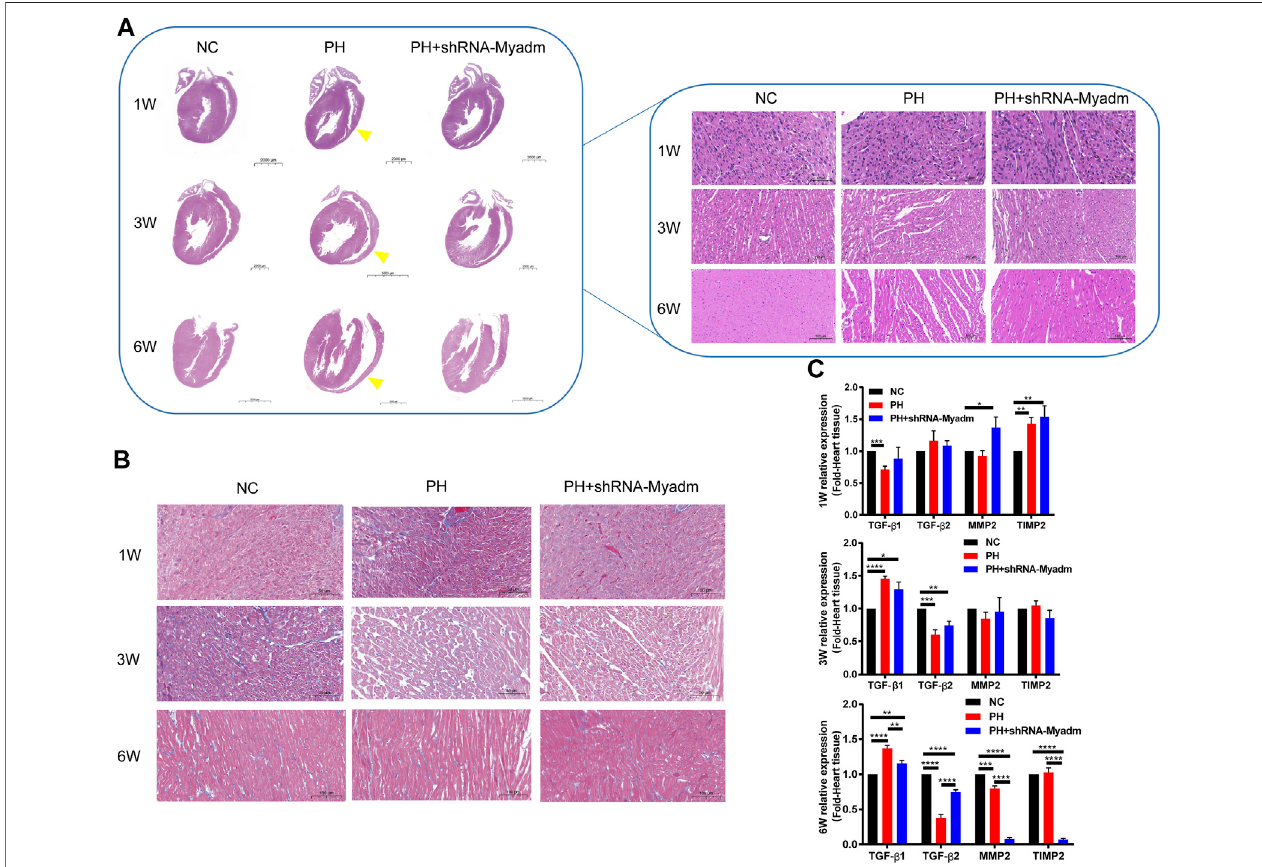
FIGURE9| Cardiac changesinrat offspring innormal, maternal PH,and interventiongroups. (A) RepresentativeH&E-stained hearts ofratoffspring at each age in each group. The left images show the entire heart, and the right images show the section of the right ventricular wall. Yellow arrows show thinner right ventricular walls and larger right cardiac chambers of maternal PH rat offspring as they grow up. (B) Representative Masson ’ s staining at each age in each group. (B) The mRNA expression ofTGF- β 1,TGF- β 2, MMP2,and TIMP2inthehearttissue ofoffspringineach groupand at each age.* p < 0.05,** p < 0.01, *** p < 0.001,**** p < 0.0001 vs. the normal pregnancy group ( n (cid:1) 6 rats per group). NC, normal control; PH, pulmonary